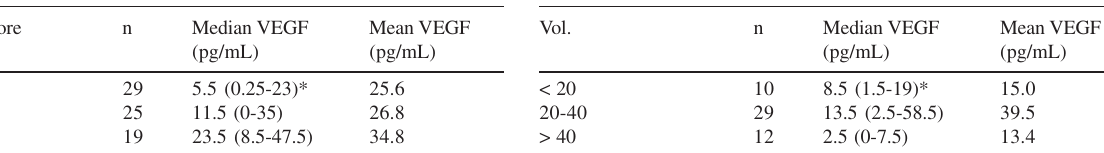
Table 5 - Plasma vascular endothelial growth factor (VEGF) according to prostate